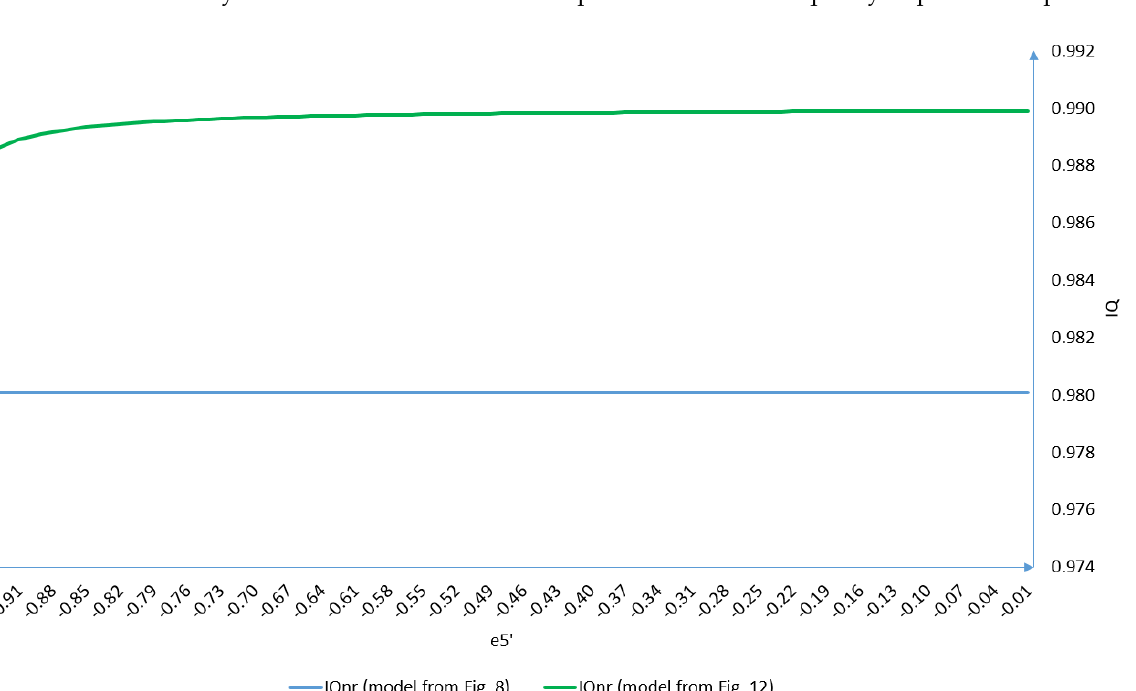
Figures 8 and 12 ( the authors’ own study). Figures 8 and 12 (the authors’ own